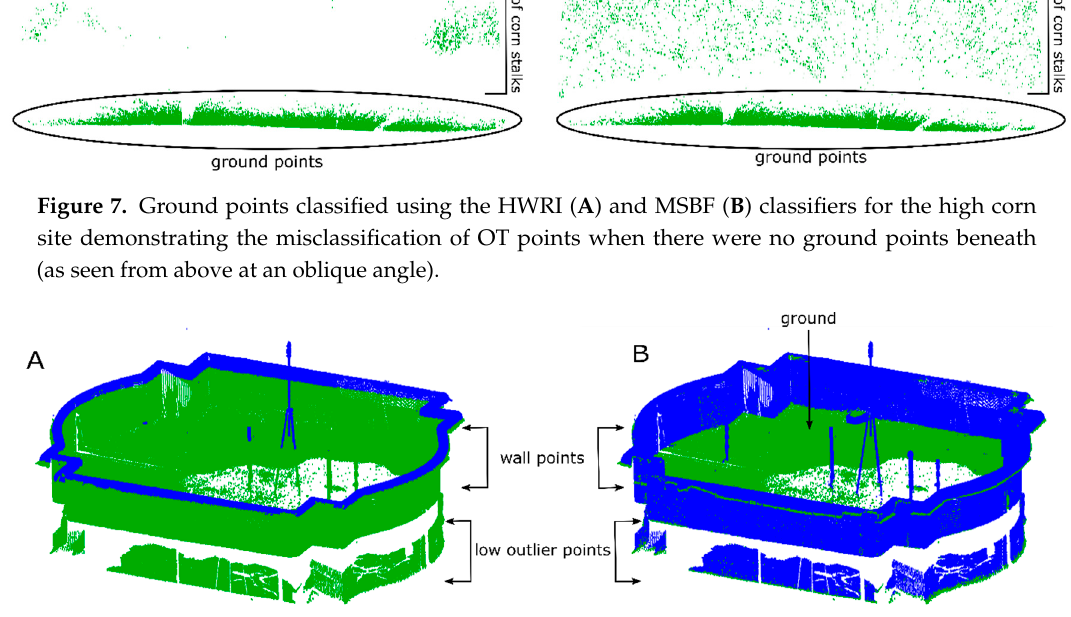
Figure 8. Classified ground (green) and OT (blue) points for the HWRI ( A ) and MSBF ( B ) classifiers showing the presence of low outlier points beneath the fountain in the garden site.